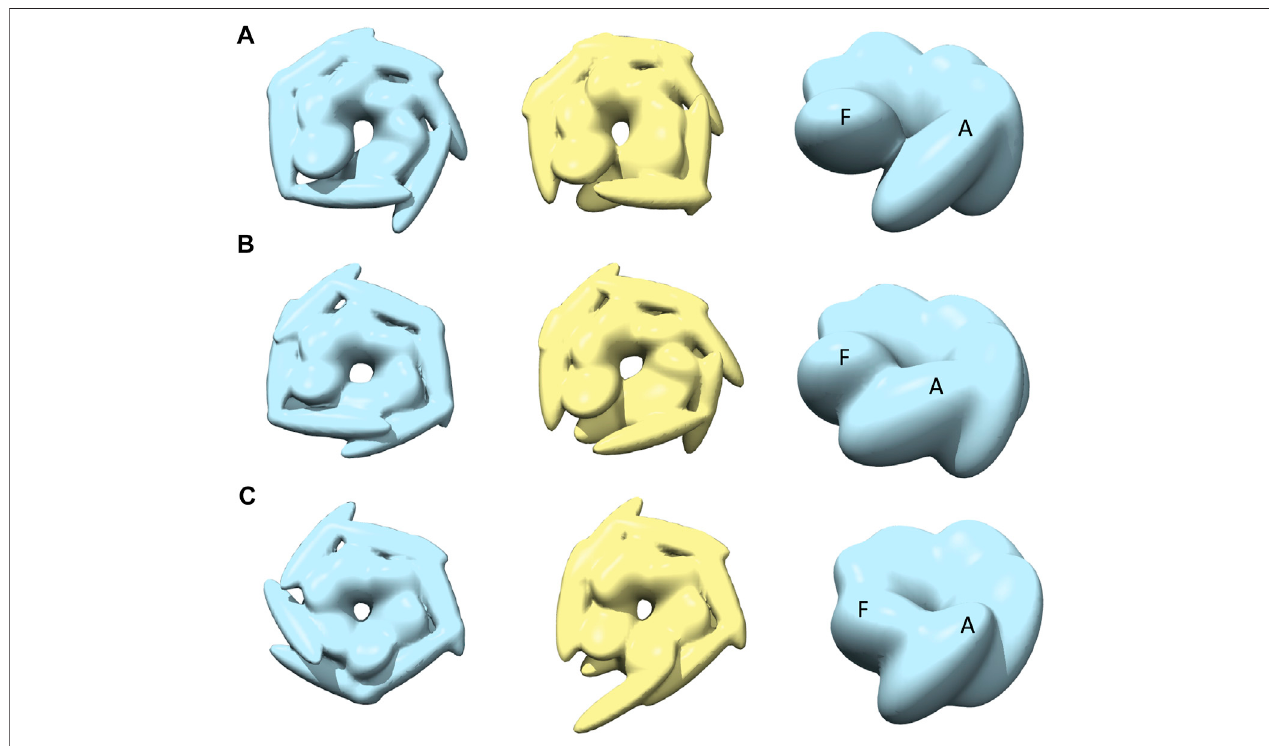
FIGURE5 | The most converged model between structural modelling starting from R (light blue) and S(yellow) for spiral class AFM images. The rows (A – C) are for AFM images 4, 5 and 6, respectively.